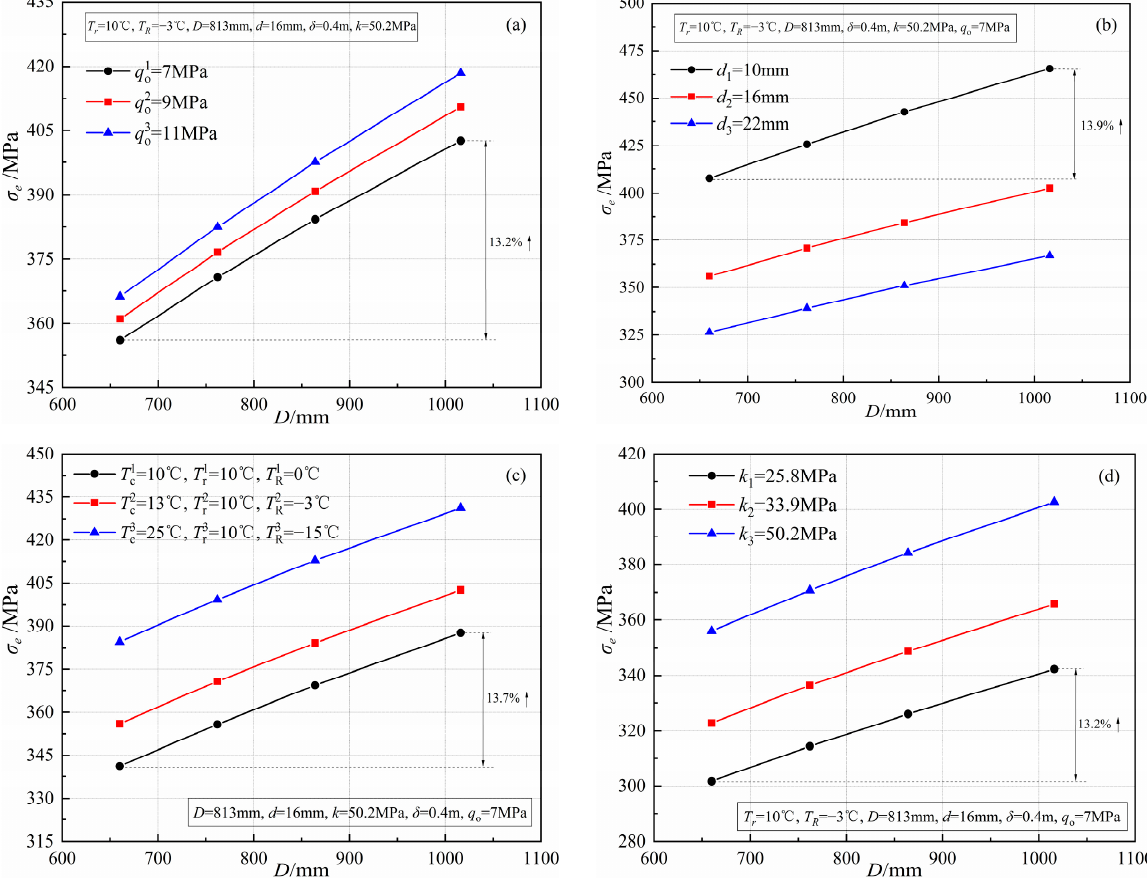
Figure 11. Variations in the equivalent stress with respect to the pipe diameter. ( a ) Under different oil pressures; ( b ) Under different wall thicknesses; ( c ) Under different temperature differences; ( d ) Under different foundation coefficients.